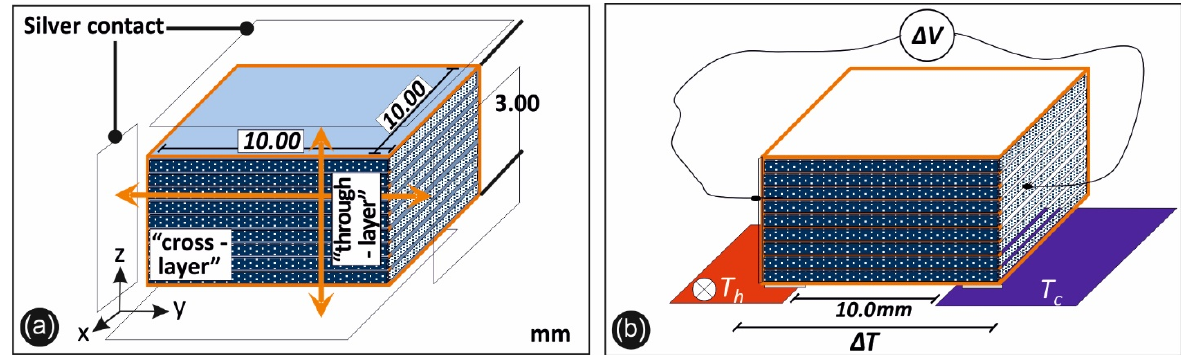
Figure 3. ( a ) Schematic illustration of the cross ‐ layer and through layer two ‐ probe electrical resistance derived conductivity measurements and ( b ) the setup employed for the Seebeck coefficient measurements of the 3D ‐ printed conductive nanocomposites.